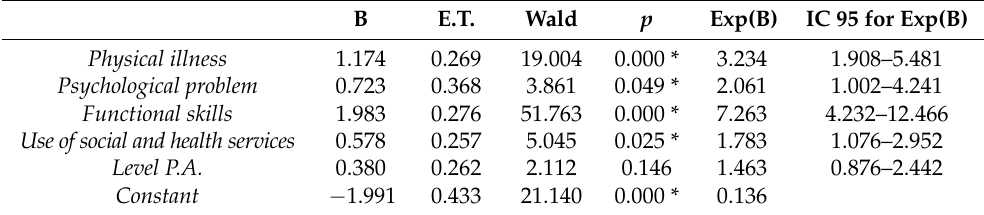
Table 3. Logistic regression model of the level of satisfaction with